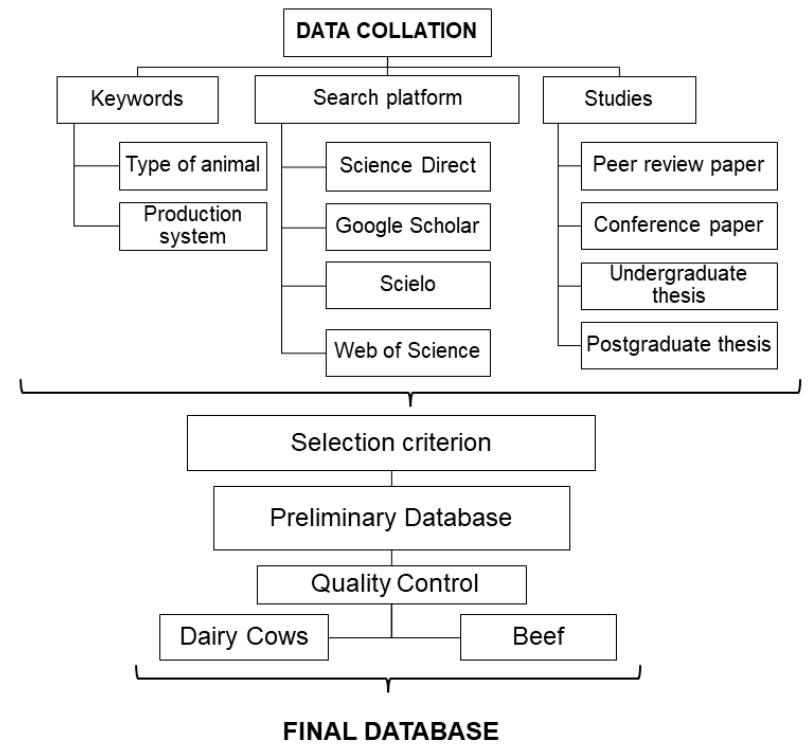
Figure 1. Summary of process for data collation.